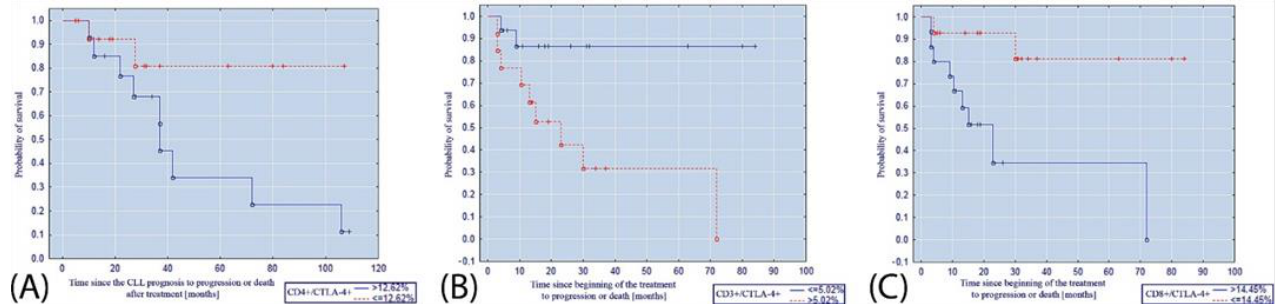
Figure 3. Kaplan – Meier curve illustrating the probability of progression-free survival ( A ) after diagnosis of CLL depend- ing on the percentage of CD4+/CTLA-4+ lymphocytes; ( B ) after the initiation of CLL treatment depending on the percent- age of CD8+/CTLA-4+ lymphocytes; ( C ) after the initiation of CLL treatment depending on the percentage of CD3+/CTLA- 4+ lymphocytes.